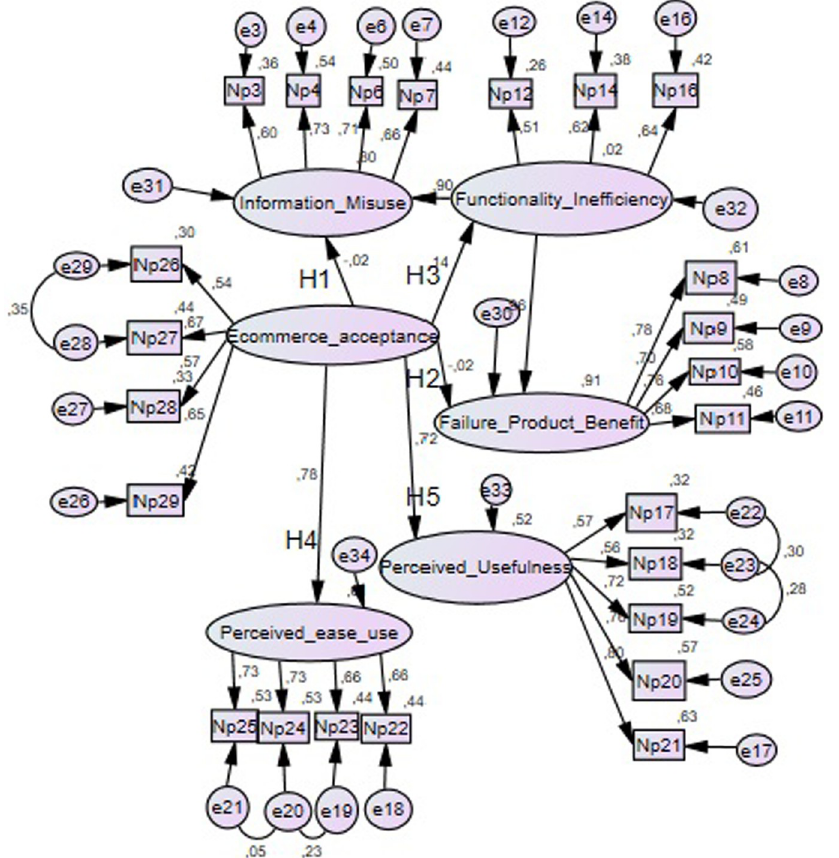
Fig 2. Structural equation model. Source: Authors.